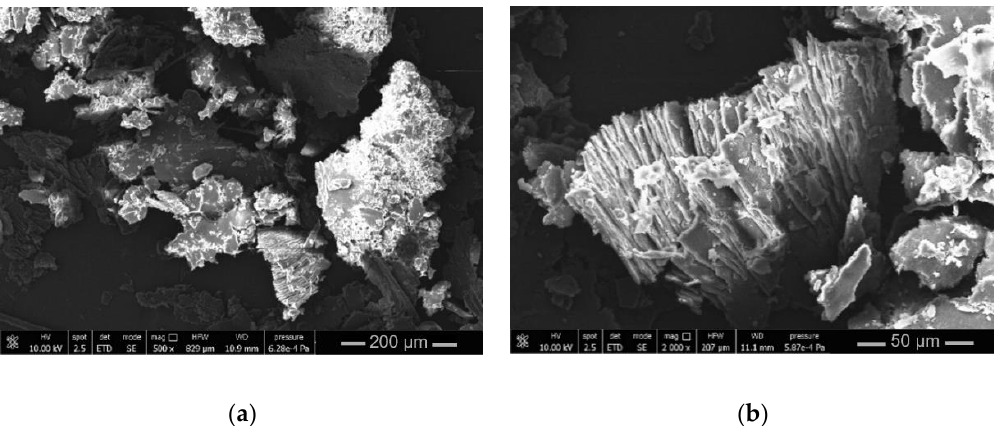
Figure 1. SEM image of SK >7000 of TSK after drying obtained after 2 h of MAE extraction. ( a ) Magnification 500×; ( b ) Magnification 2000×.